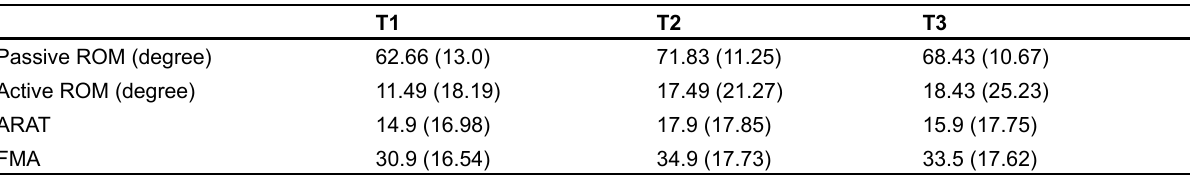
Table 3. Mean (standard deviation) of clinical variables ( n = 10) T1 T2